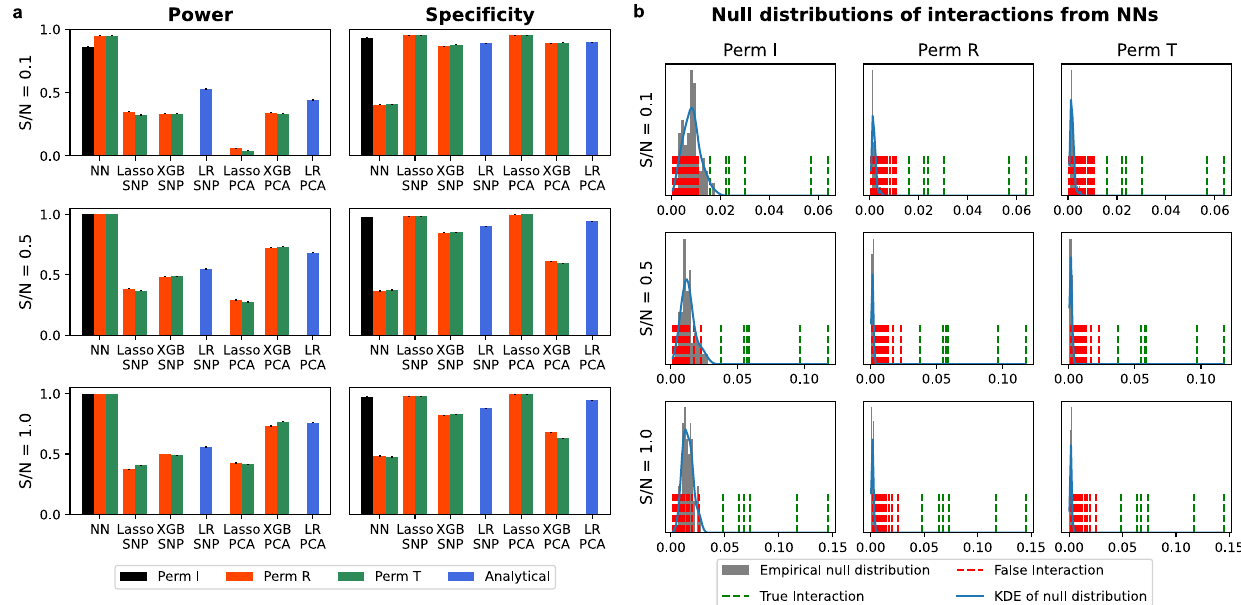
Fig. 2 Comparison of interaction detection methods with different permutation algorithms. a Comparison of the power (true positive rate) and speci fi city (true negative rate) of different methods on simulated datasets with complex interactions for different S/Ns. Error bars are estimated with 20 different simulations. Null distributions of linear regression (LR) are derived analytically (with 80k samples), and null distributions without analytical forms are constructed by three permutation methods (with 50 random permutations) with the maxT correction. We consider interaction as positive (i.e. detected) if its p -value obtained from the null distribution is less than 0.05. NNs (black bars) have greater power and similar speci fi city compared with other approaches when interactions are tested with the proposed Perm I. With existing permutation approaches (Perm R and Perm T), NNs have much smaller speci fi city in all settings. b Examples of null distributions of interactions from NNs for the three different permutation methods on simulated datasets with complex interactions and different S/Ns. We visualize each null distribution with the empirical distribution and the kernel density estimate (KDE). Green/red dashed lines show all true/false interactions. The null distributions generated by Perm I correctly reject false interactions, while Perm T and Perm R consider most false interactions positive.